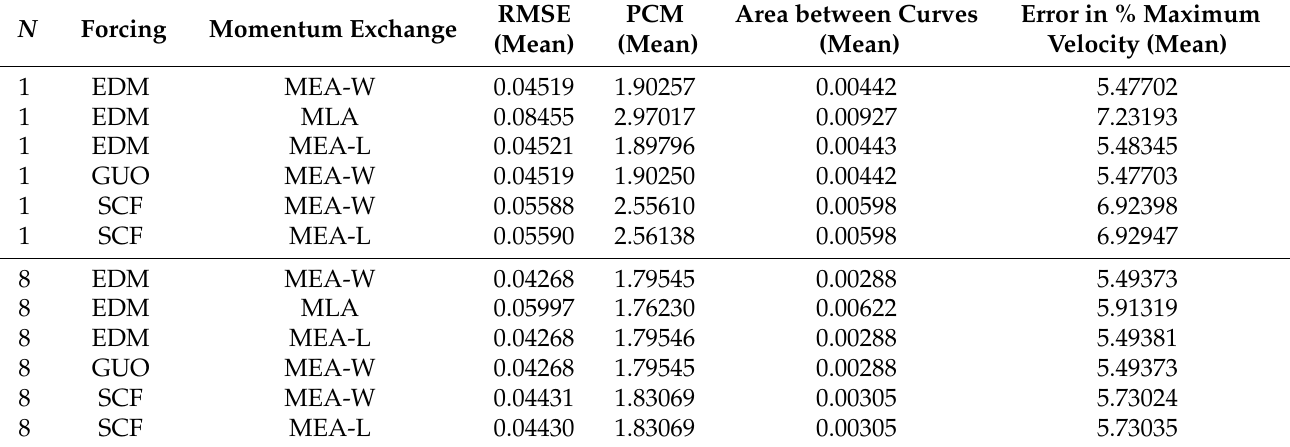
Table 4. Mean values of the results presented in Tables 2 and 3. The averages are taken over the four application